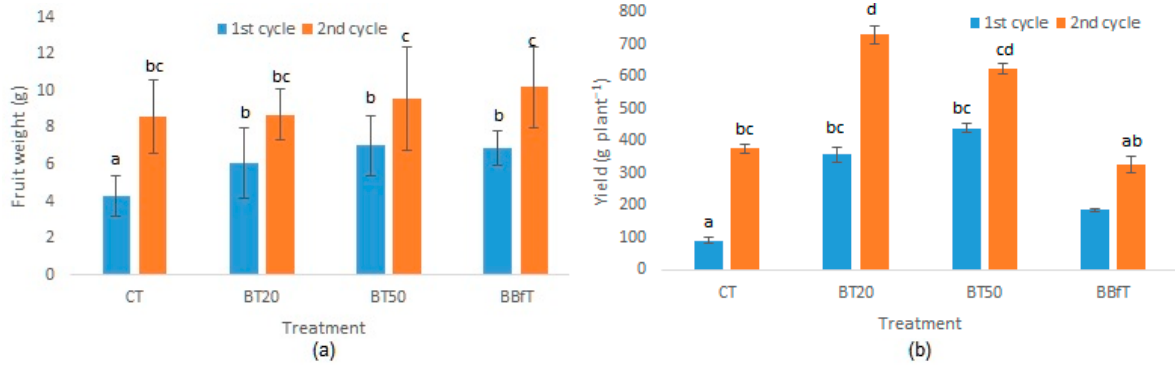
Figure 5. ( a ) Fruit weight and ( b ) Yield of Physalis ixocarpa with different treatments: CT: soil + 100% of chemical fertilization, BT20 and BT50: soil + biochar + 100, 20, or 50% of chemical fertilization, respectively, and BBfT: soil + biochar + biofertilization. Different letters indicate significant difference ( p < 0.05, Duncan test).